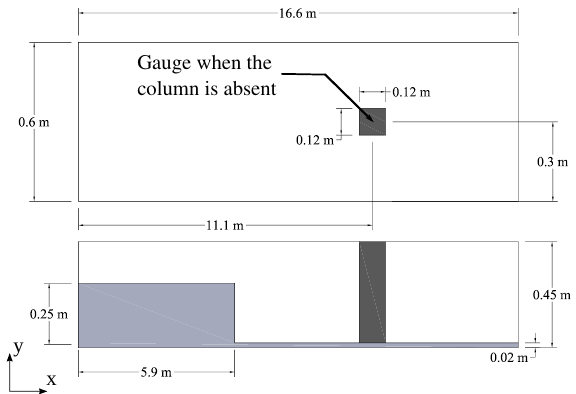
Figure 1. Schematic of the experimental setup for the interaction between bore and square column. The top figure shows a plan view, and the bottom figure shows a cross section through the center of the column, also illustrating the bore. (Reprinted with permission from Motley et al., 2015. Copyright by ASCE.)